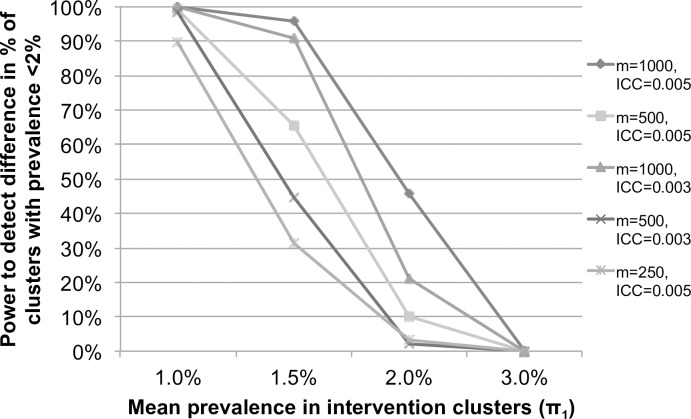
Power to detect a difference in the proportion of clusters achieving transmission interruption (Primary Objective 2) assuming 7% mean prevalence in the targeted clusters (π0), by mean endline prevalence in the intervention clusters (π1), intracluster correlation (ICC) and number of people measured per cluster (m), estimated by simulation.